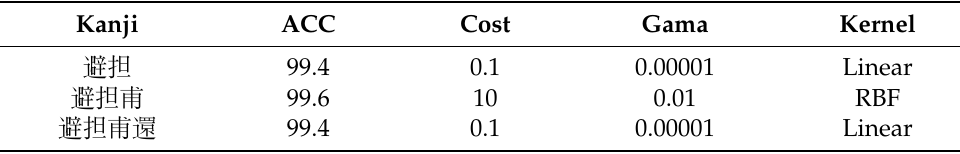
Table 5. Identification accuracy (in %) of connected characters. Kanji ACC Cost Gama